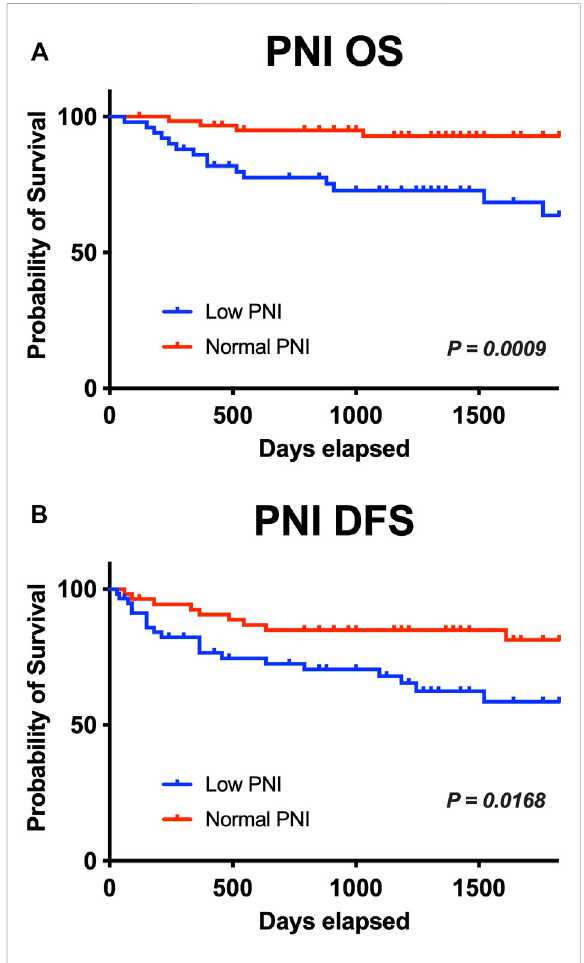
FIGURE 3 The low preoperative PNI group had lower survival rates. (A, B) Theoverall survivalrateanddisease-freesurvivalrateinpatients withalowPNIweresigni fi cantlylowerthanthoseinpatientswitha normal PNI ( p = 0.0009 and p = 0.0168). PNI, prognostic nutritional index; OS, overall survival; DFS, disease-free